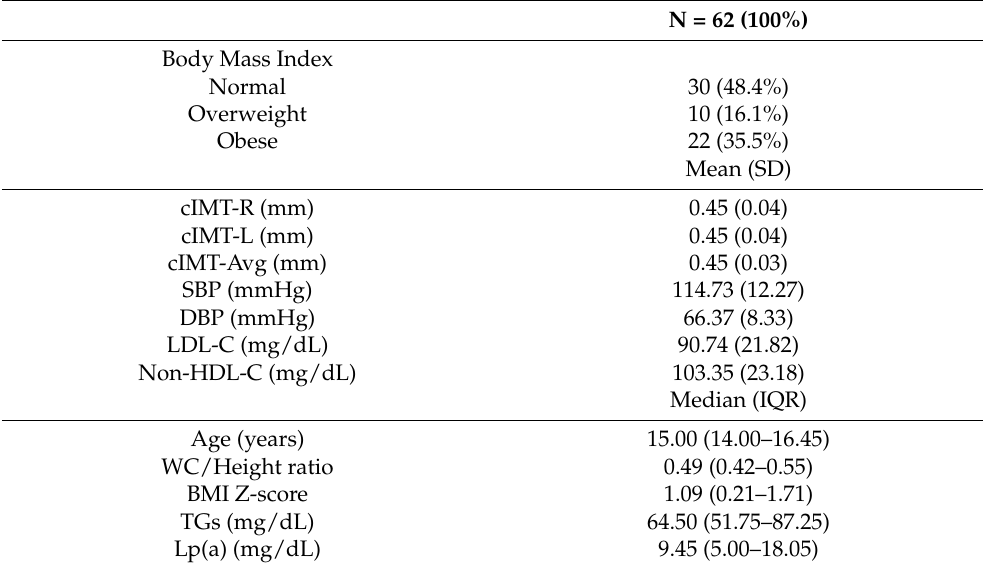
Table 2. Population clinical, laboratory, and imaging